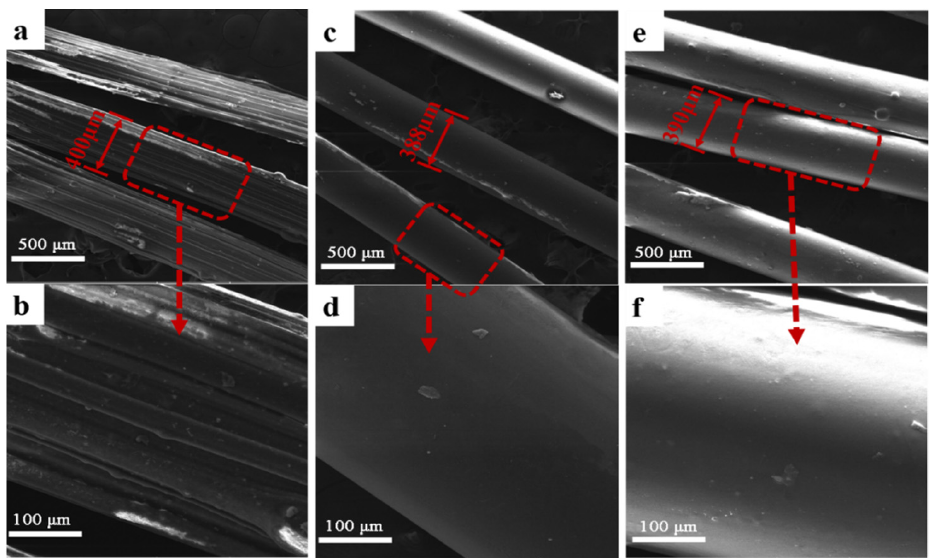
Figure 7. Morphological structure and dispersion of CLCCs in hybrid fluorescent fibers. SEM images: ( a , b ) ETPC fibers, ( c , d ) ETPC-SA fibers, and ( e , f ) ETPC-HQ fibers. 3.5. Morphological and Crystalline Structures of ETPC, ETPC-SA, and ETPC-HQ